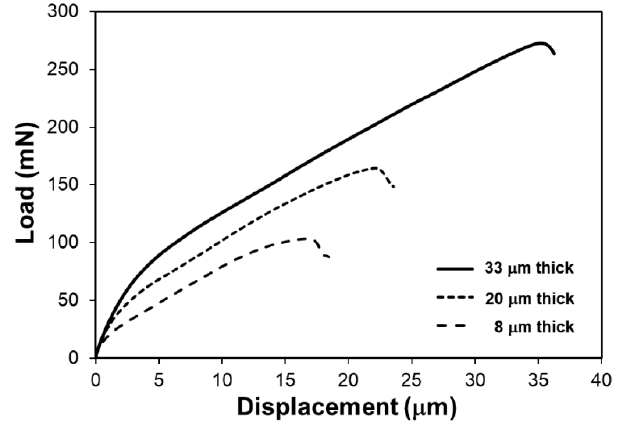
Figure 12. Load–displacement curves for T91 steel obtained during micro-punch tests on DS membranes.